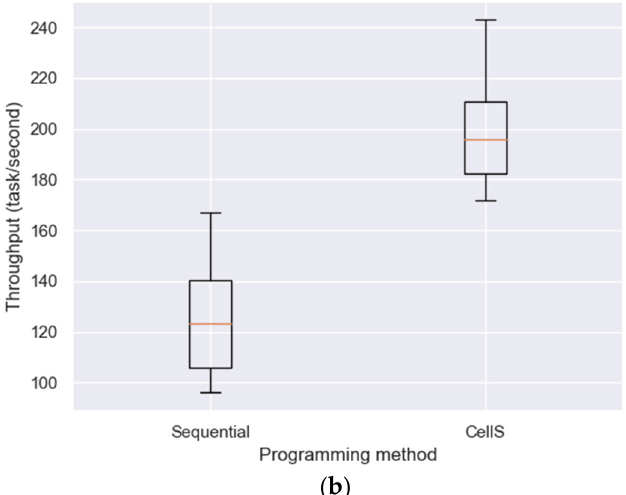
Figure 16. The throughput produced by different numbers of CPU cores: ( a ) Qualcomm Snapdragon MSM8916 410 and ( b ) Qualcomm Snapdragon 810.